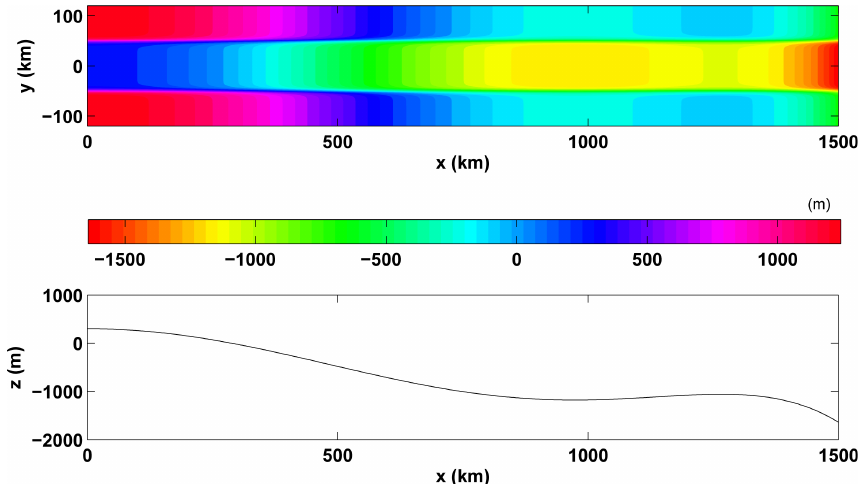
Fig. 1. Bedrock geometry. Upper panel: map-plane view of bedrock geometry with a corresponding colorbar below. Lower panel: longitudi- nal section of bed along the medial line ( y =